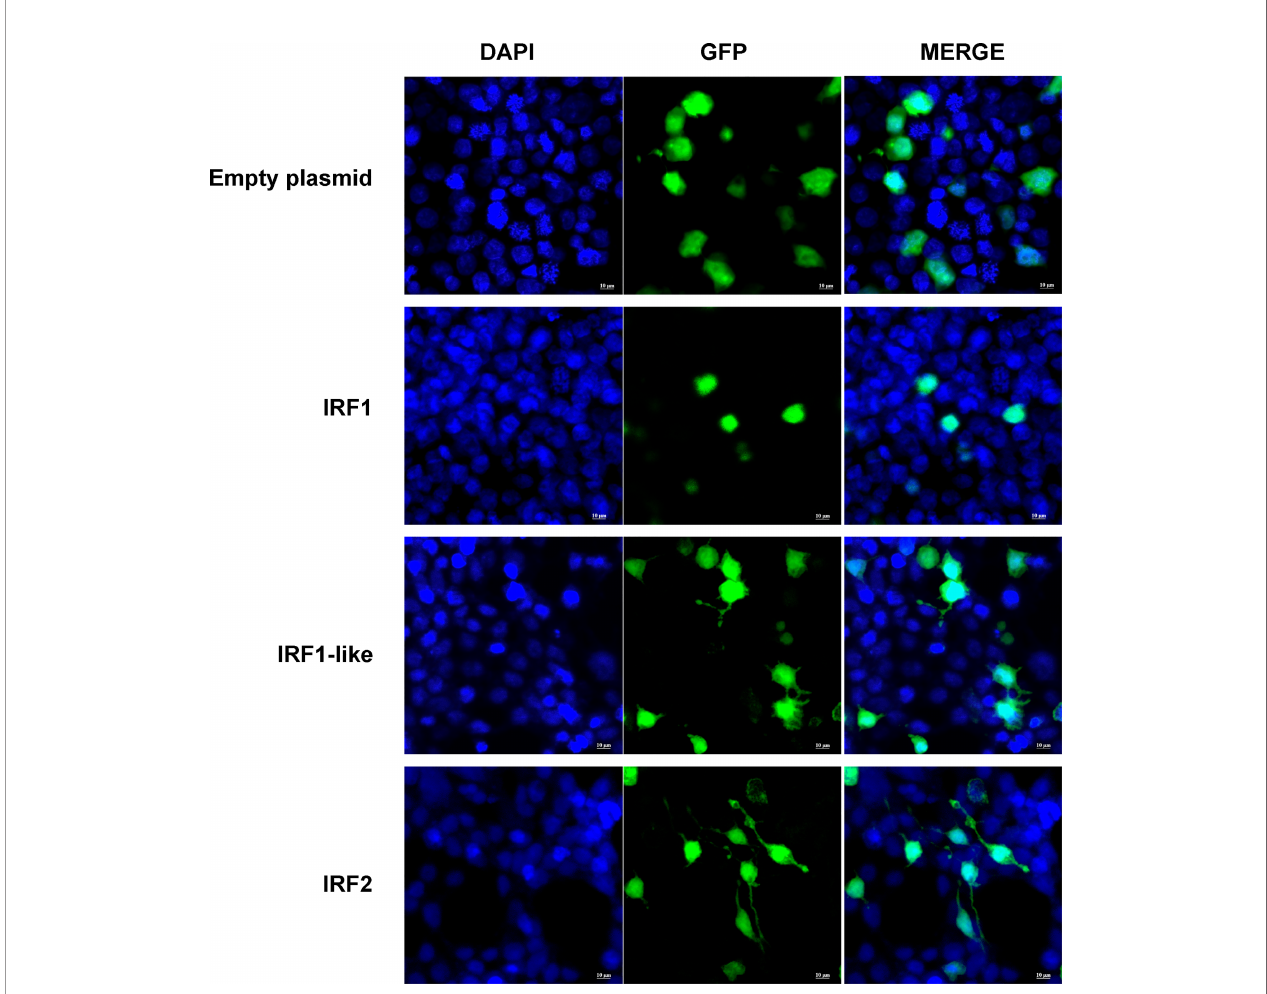
FIGURE 6 | Subcellular localization of CfIRF genes in HEK293T cells. Immunohistochemistry was performed to analyze the expression of Cf IRF in hemocytes. The left-hand panels depict DAPI staining, the middle panels depict GFP staining, and the right-hand panels depict merged DAPI/GFP staining. The upper panels depict localization of the GFP negative control, and the lower panels depict localization of the Cf IRF-GFP